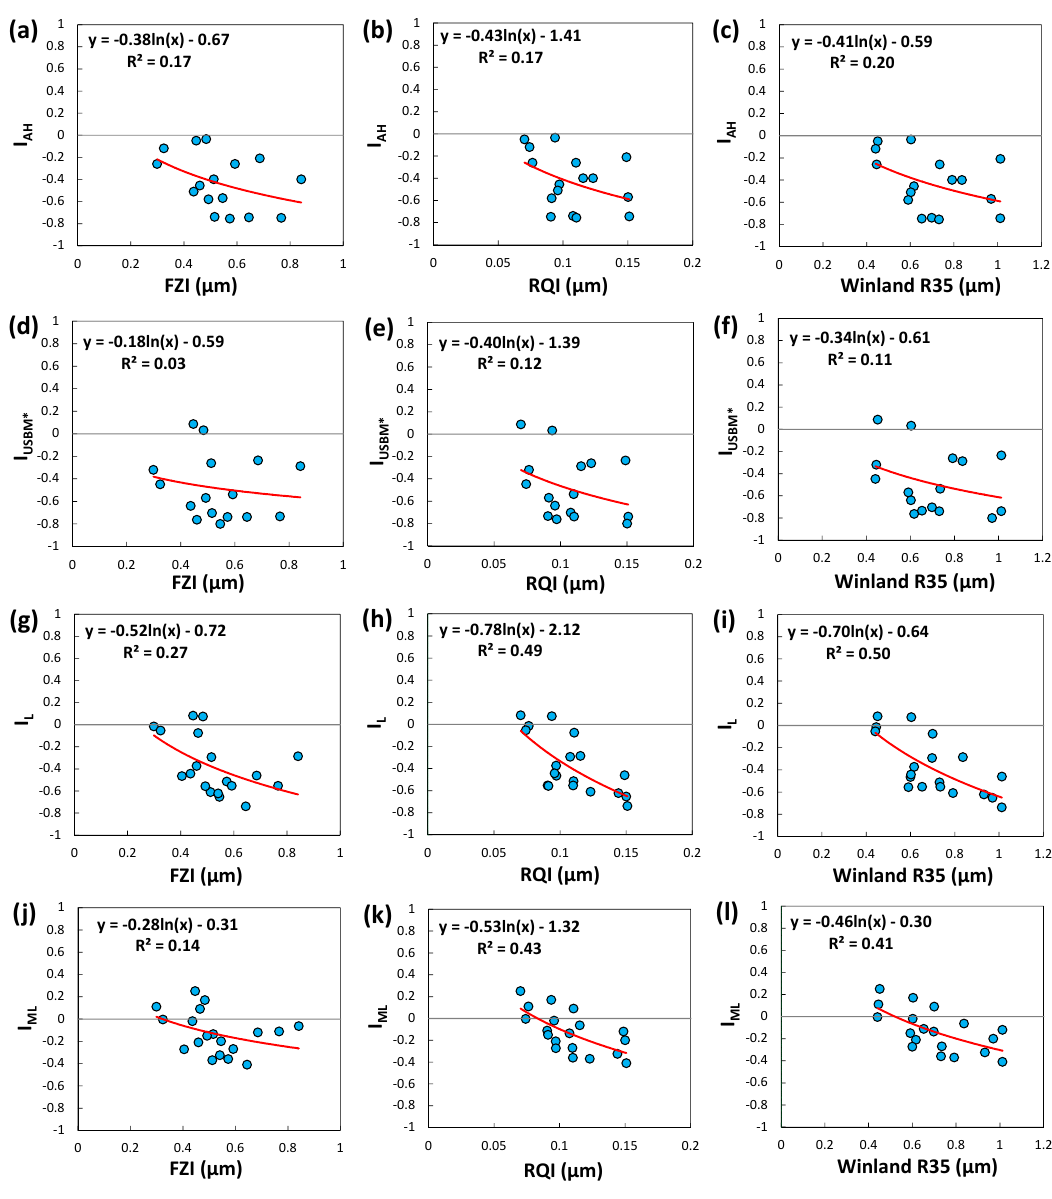
Figure 6. Different wettability indices versus rock quality indicators for the carbonate rock samples used in this study. ( a ) Amott-Harvey vs. FZI , ( b ) Amott-Harvey vs. RQI , ( c ) Amott-Harvey vs. Winland R 35 , ( d ) USBM* vs. FZI , ( e ) USBM* vs. RQI , ( f ) USBM* vs. Winland R 35 , ( g ) Lak vs. FZI , ( h ) Lak vs. RQI , ( i ) Lak vs. Winland R 35 , ( j ) modified Lak vs. FZI , ( k ) modified Lak vs. RQI , ( l ) modified Lak vs. Winland R 35 .